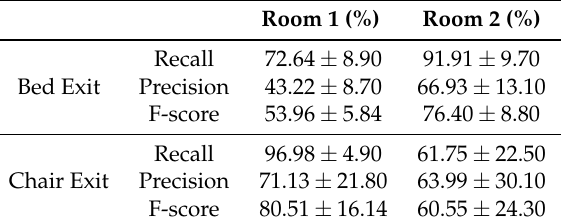
Table 2. Bed and chair exit recognition using previous method in